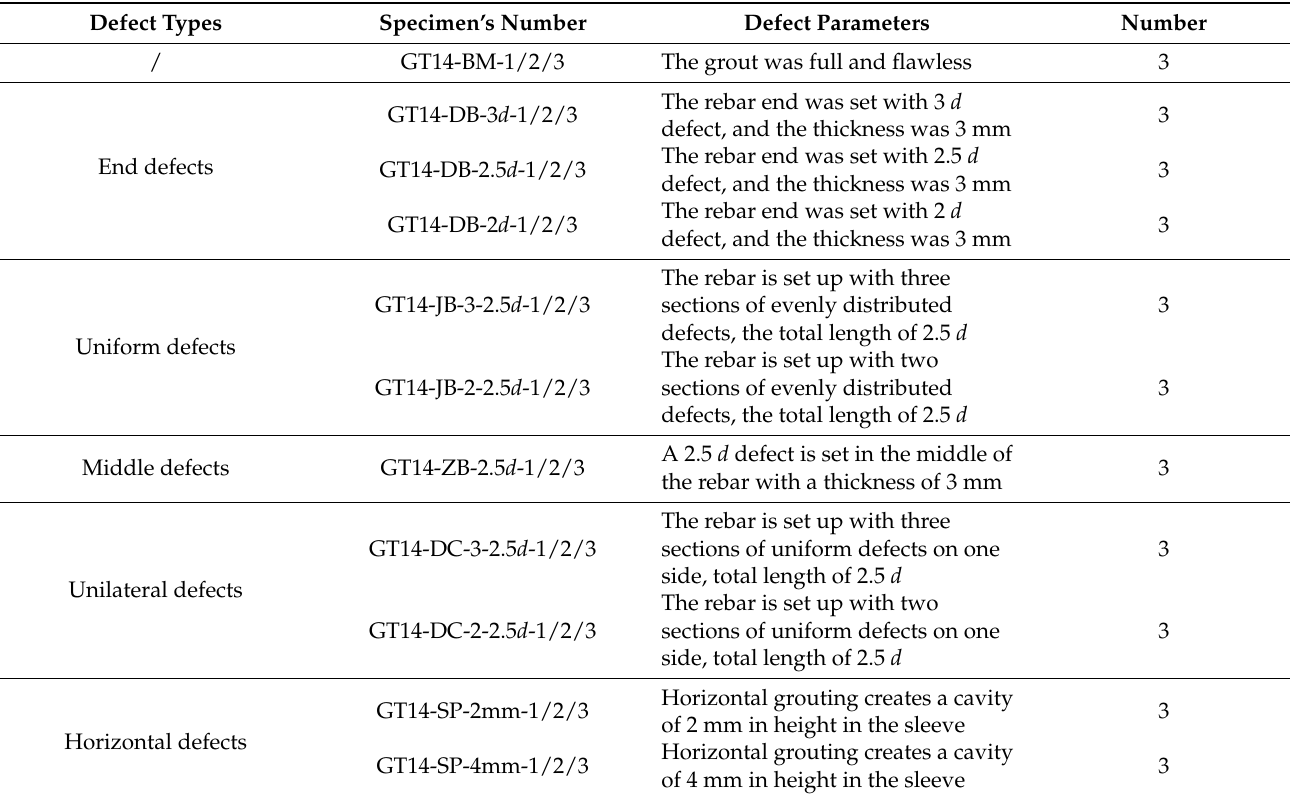
Table 8. presents the design parameters of the above 11 groups of specimens. Table 8. Presents the design parameters of the above 11 groups of